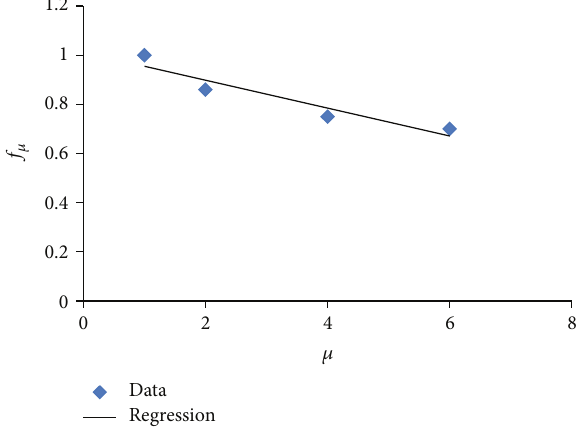
Figure 6: Evaluation of 𝑓 𝜇 with respect to 𝜇